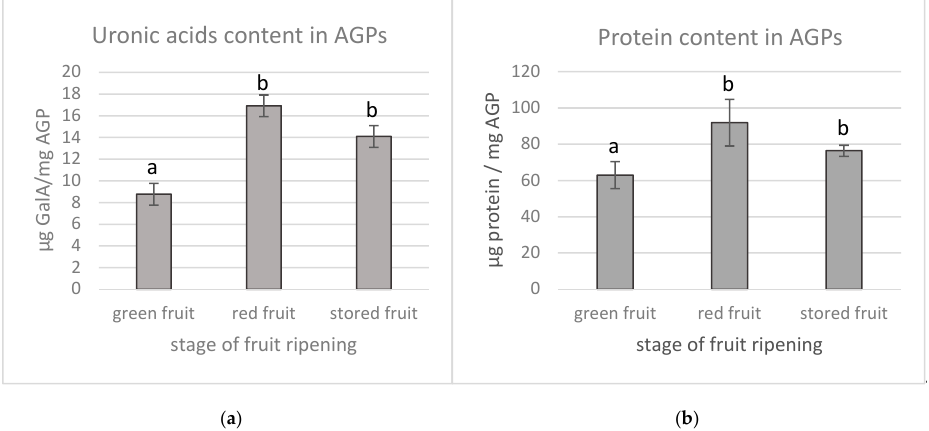
Figure 2. Qualitative analysis of uronic acids ( a ) and protein content ( b ) in AGPs extracted from green, red and stored apple fruit. Results are expressed in µg per mg of AGPs. Different letters indicate significant differences among the development stages (according to ANOVA with p < 0.05).